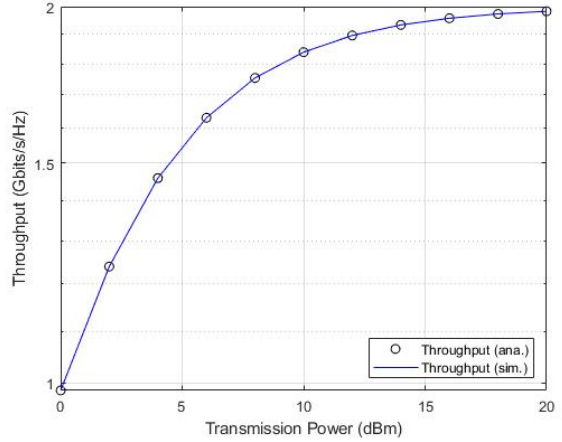
Figure 12. Sum throughput versus transmission power.